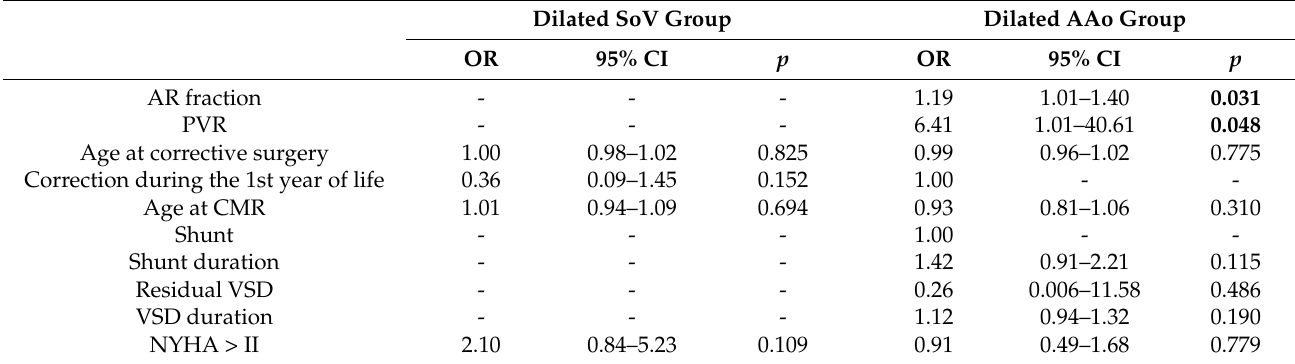
Table 4. Predictors of dilatation sinus of Valsalva and ascending aorta by logistic regression in multivariate